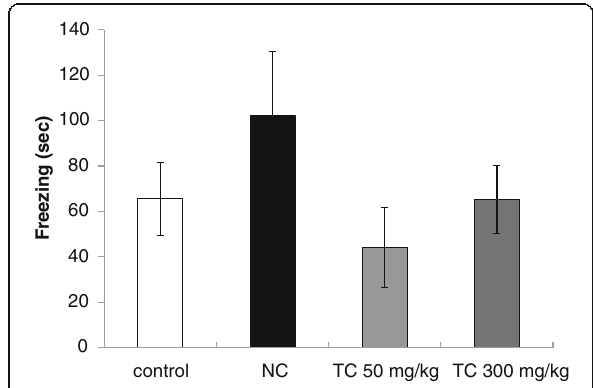
Fig. 4 Effect of treatment with Trichilia catigua (TC) hydroalcoholic extract (50 and 300 mg/kg, p.o.) for 21 days on the amnesia induced by scopolamine (2 mg/kg, i.p.) on classical fear conditioning in mice. NC = negative control (did not receive scopolamine). The columns and bars express the mean ± SEM ( n = 9 – 10). ANOVA,